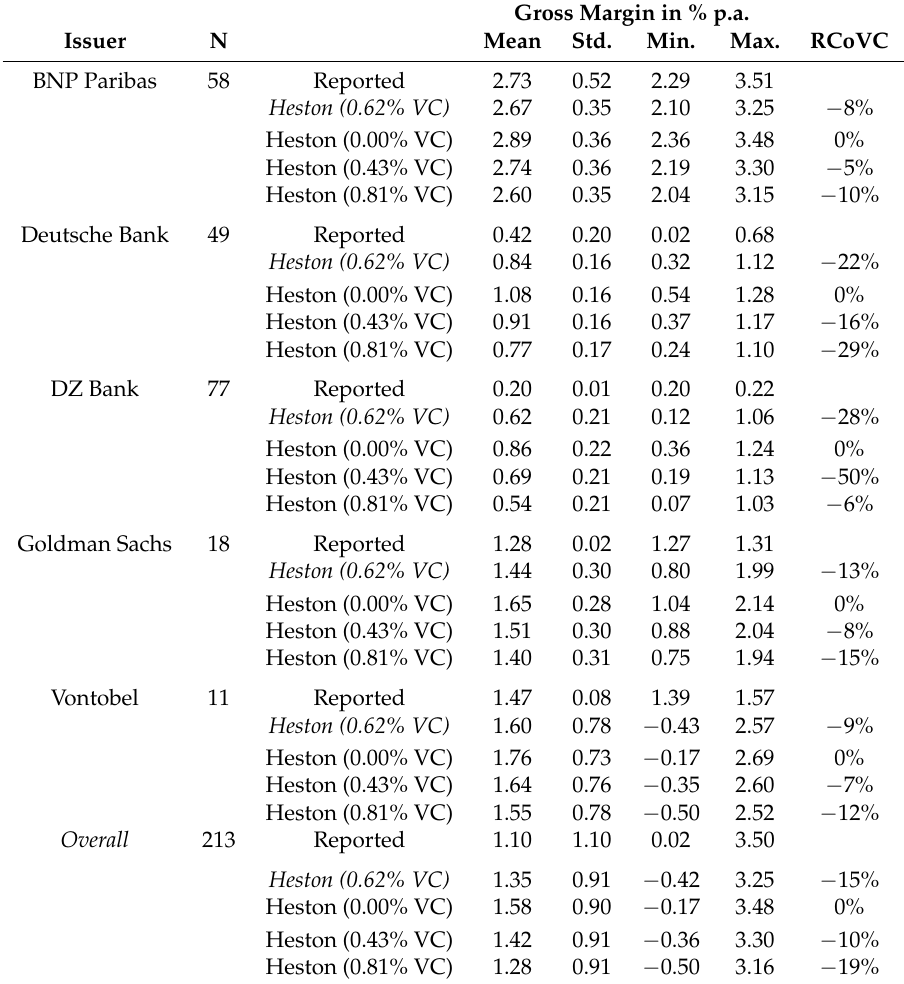
Table 6. Impact of Hedging Costs on Heston Margins (Capped Bonus Certificates). Gross Margin in %